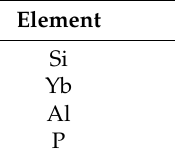
Table 7. EDX measurement: Element doping ratio in atomic percentage (excluding oxygen) for a powder derived from sol-gel with high P content [7]. Element at. %